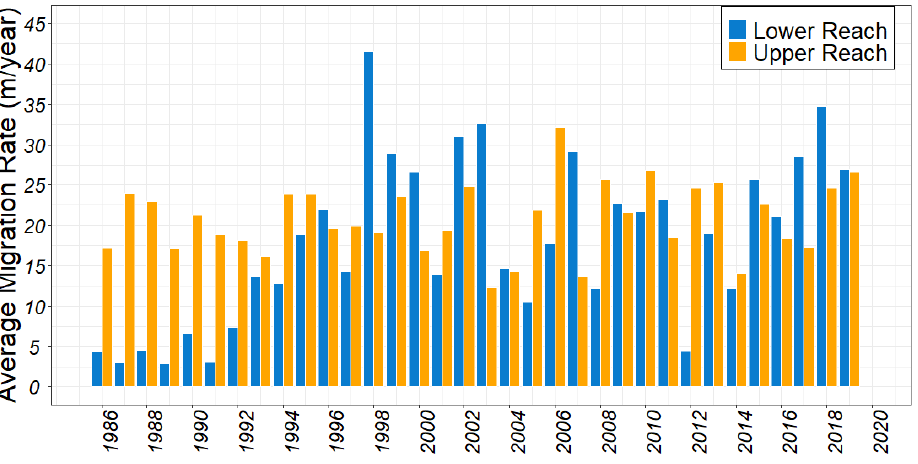
Figure 5. Migration rates for upper and lower reaches of the JH bend (see Figure